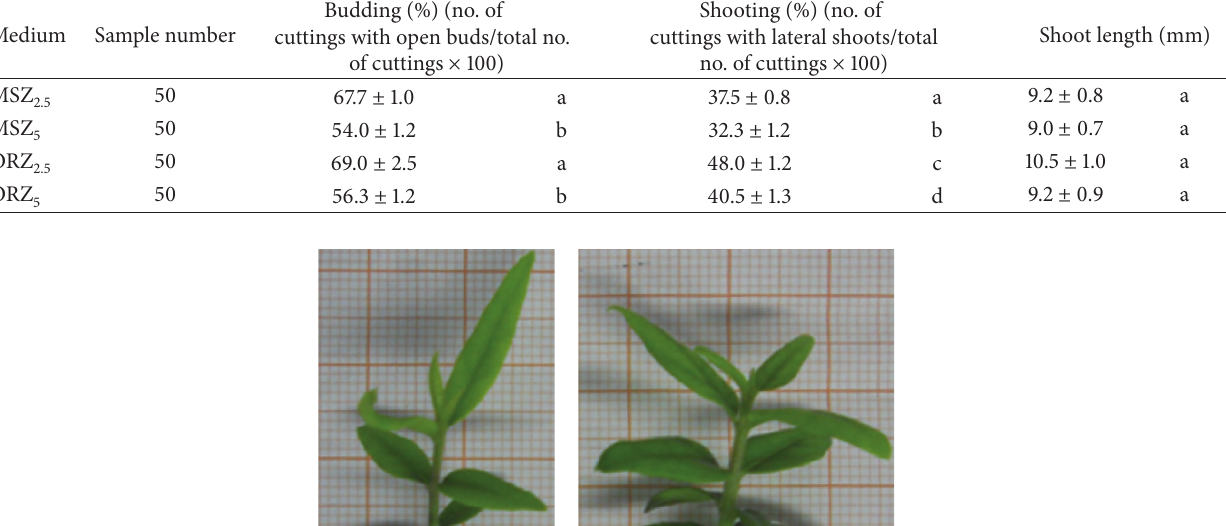
) of Olea europaea L. subsp. europaea var . s